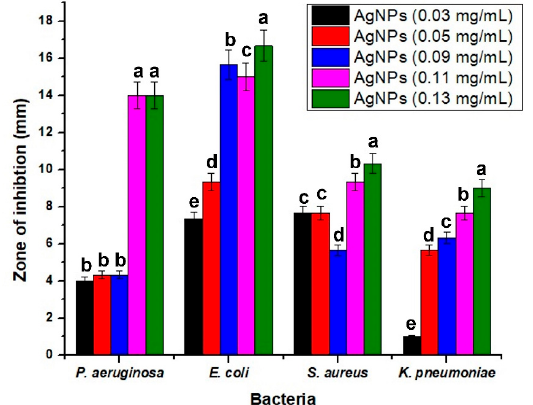
Figure 7. Antibacterial activity of AgNPs at different concentrations against four microorganisms ( P. aeruginosa , E. coli , S. aureus and K. pneumoniae ). All values are the means of 3 replicates, the error bars represent the standard errors of the means, and different letters indicate the significant difference at p = 0.05 by LSD test in each group.